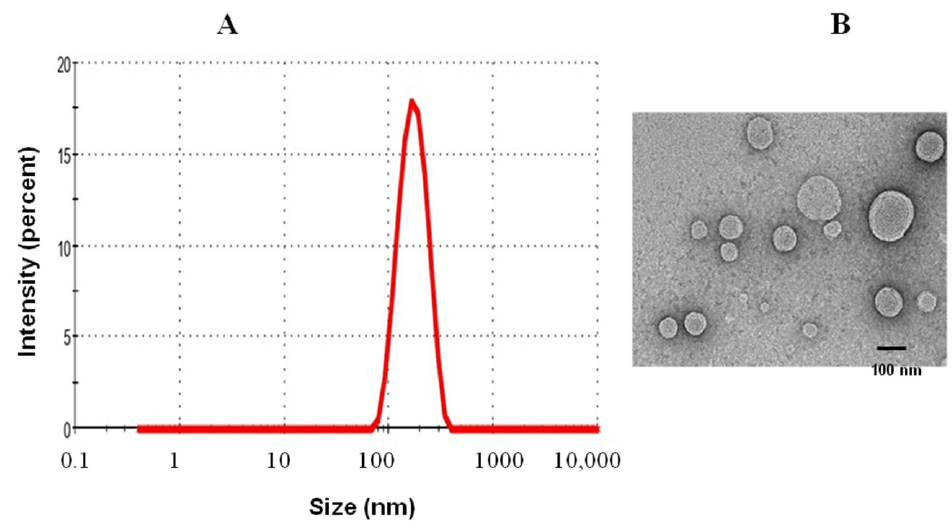
Figure 1. Characterization of DRVs. ( A ) Size of liposomes by DLS technique; ( B ) shape and size of liposomes by TEM.